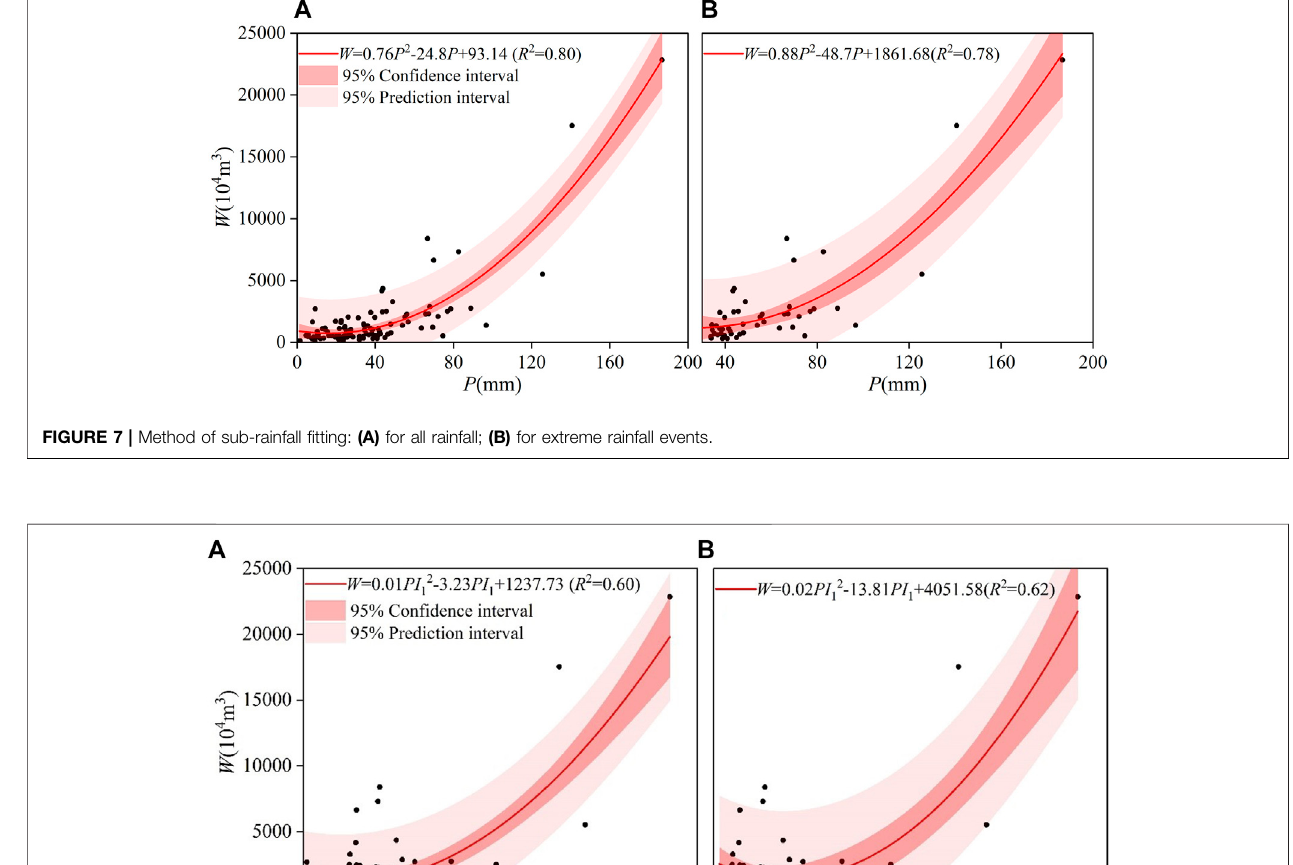
Frontiers in Environmental Science |